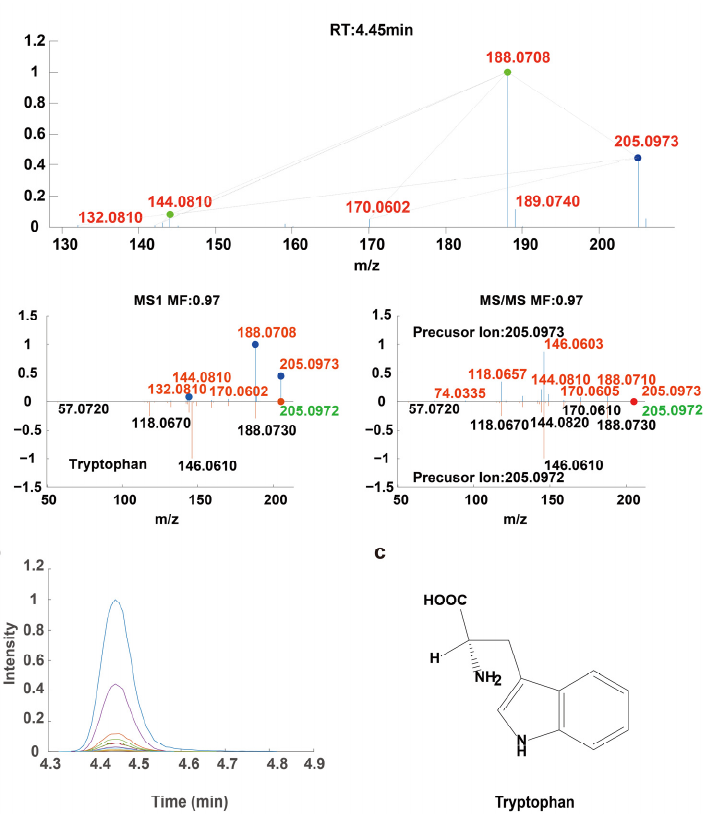
Figure 4. Example of the compound identification process with AntDAS. ( a ) The MS 1 and MS/MS spectra of the compounds with m / z of 205.0973 were constructed with AntDAS. ( b ) The EIC plot corresponding to each fragment ion. ( c ) The final identification result of the compound. Table 1. The results of the compounds identified with MS 1 and MS/MS constructed with AntDAS in the positive ion mode.